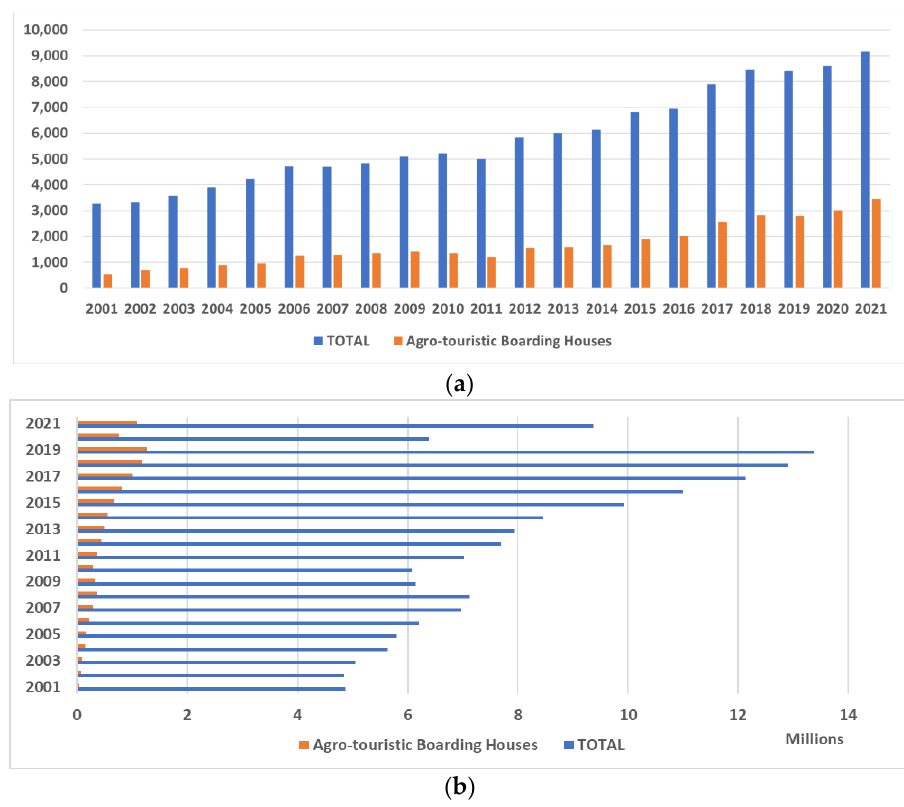
Figure 1. ( a ) Touristic reception establishments with functions for tourist accommodations; ( b ) num- ber of tourists accommodated (in the structure of tourist reception). Data source: National Institute for Statistics.